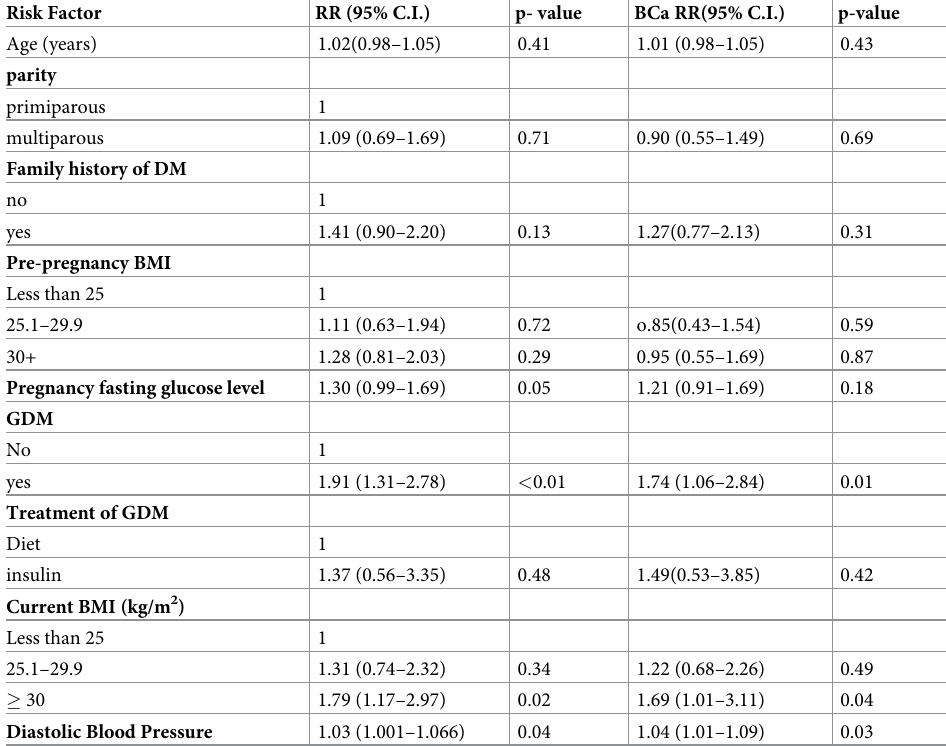
RR, Relative risk; BCa C.I., Bias Corrected and accelerated confidence interval; C.I., Confidence intervals; DM, Diabetes mellitus; GDM, Gestational